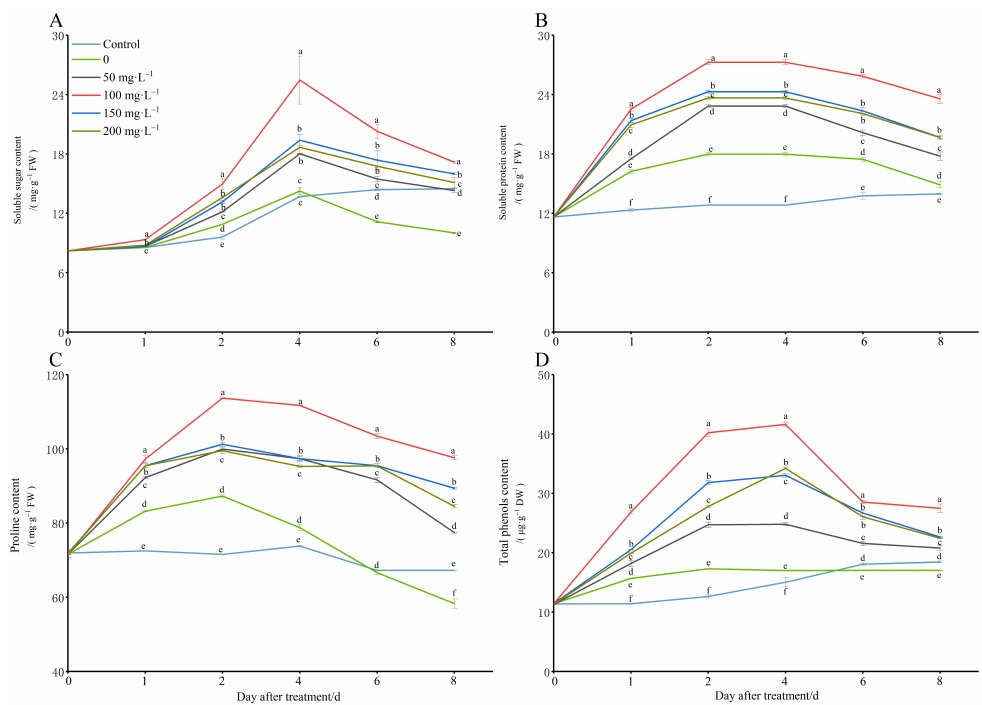
Figure 5. Changes in osmotic substance contents of peanut seedlings under low-temperature condi- tions (8 ◦ C). On each subgraph, different letters in the same column indicate significant differences in the p < 0.05 level. Data in the figure are presented as the mean ± standard deviation (n =